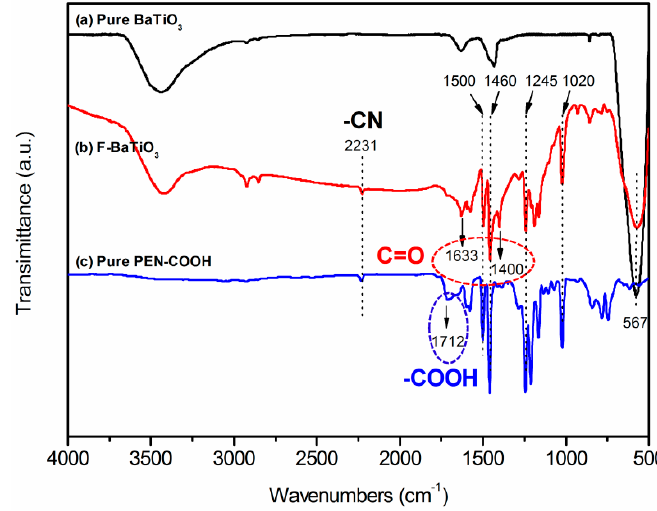
Figure 3. FTIR spectra of: ( a ) pure BaTiO 3 ; ( b ) F-BaTiO 3 ; and ( c ) pure PEN–COOH.